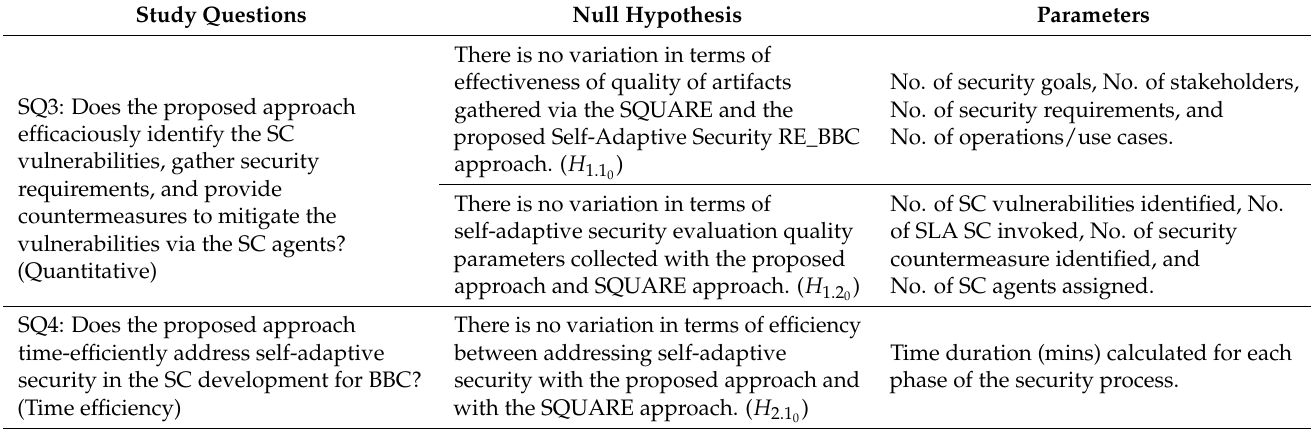
Table 3. Study Questions, Hypothesis and Parameters defined for Empirical